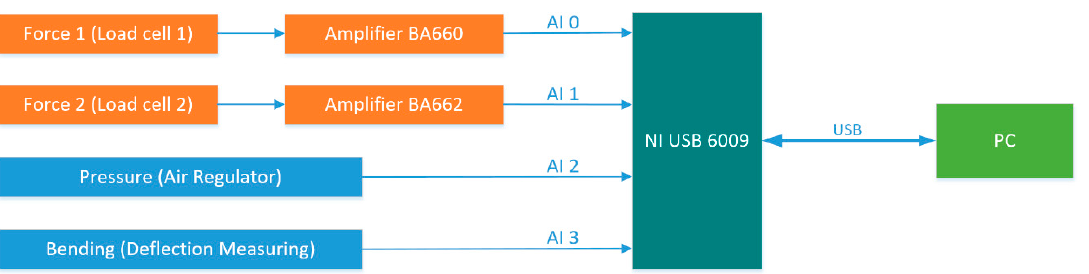
Figure 11. Block diagram of the measuring system of the testing rig.